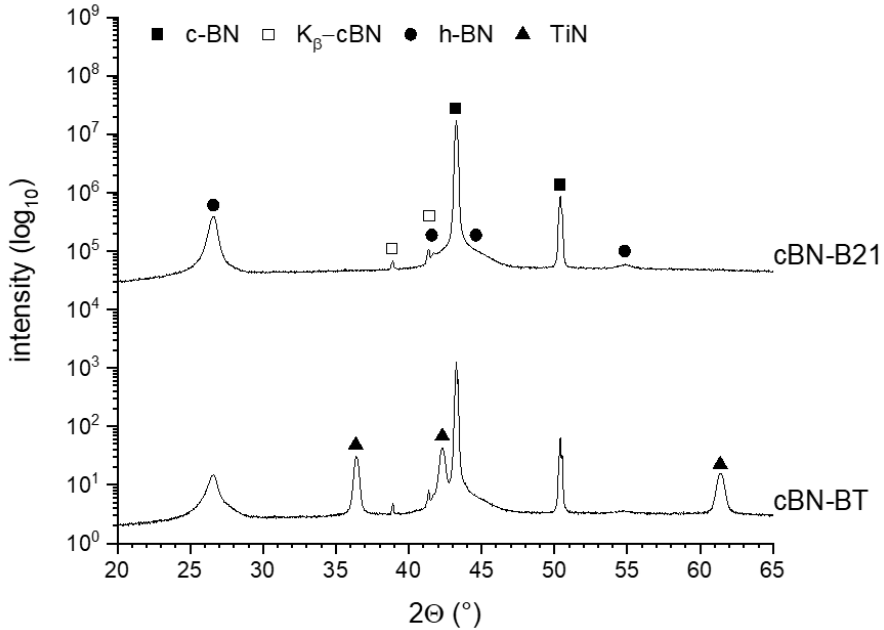
Figure 8. XRD patterns of the investigated cBN powders tempered at 1600 °C under nitrogen (the logarithmic scaling emphasizes the minor phases with low peak intensity).